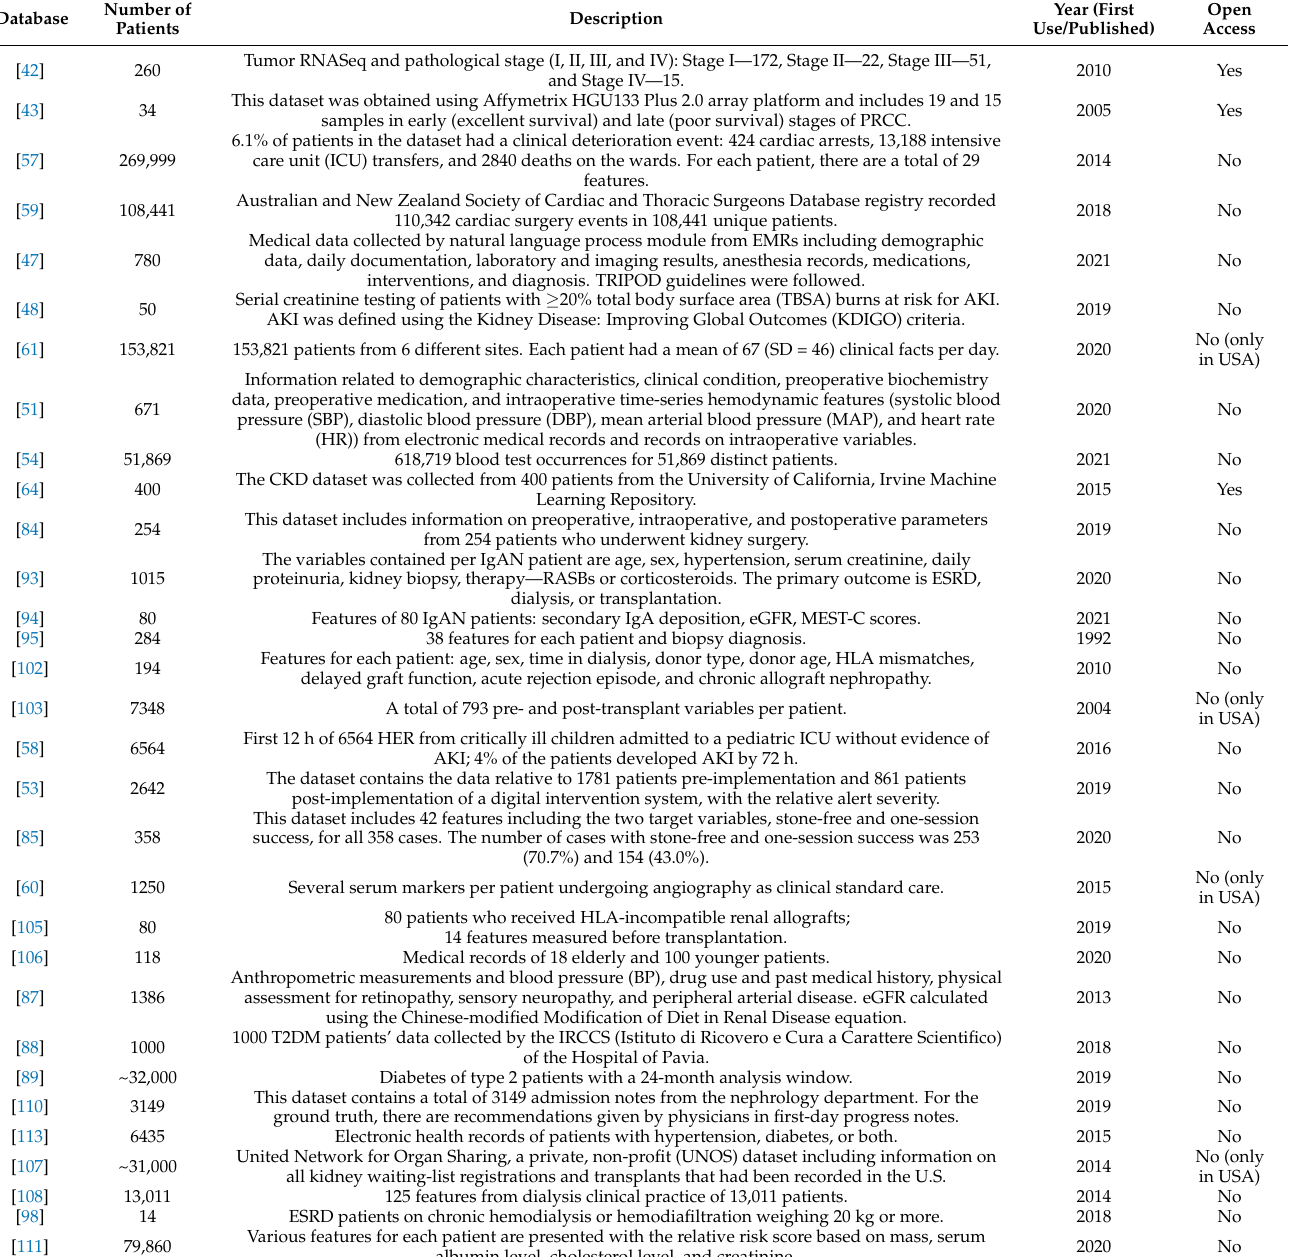
Table 9. Numerical databases.